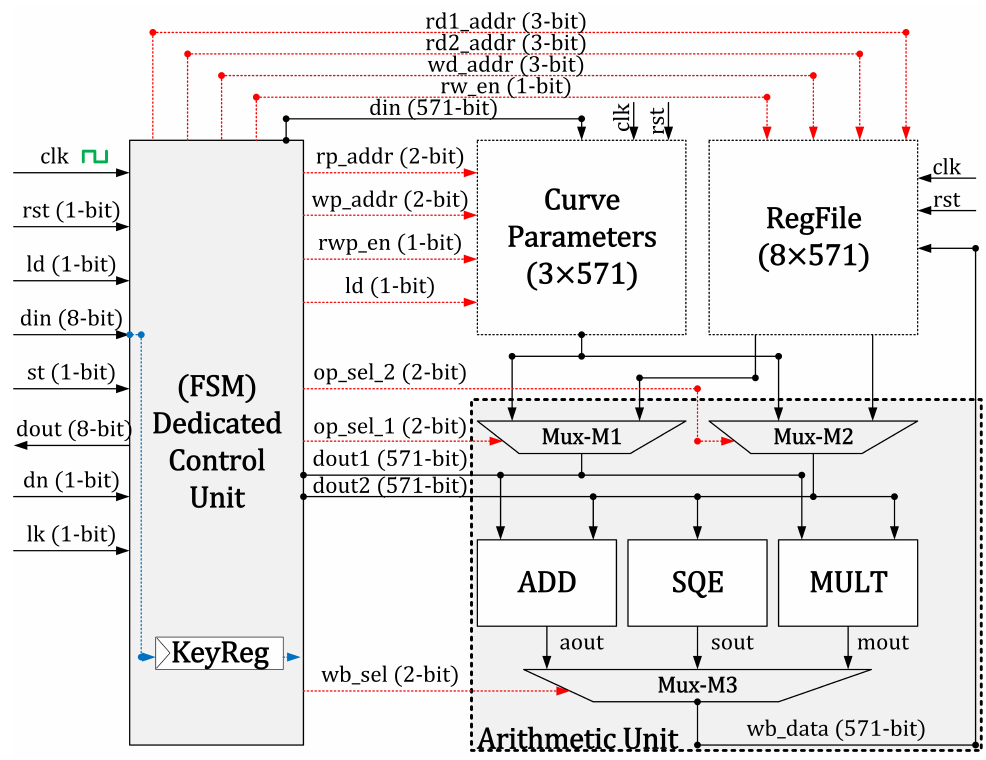
Figure 1. Our large field-size elliptic curve cryptographic